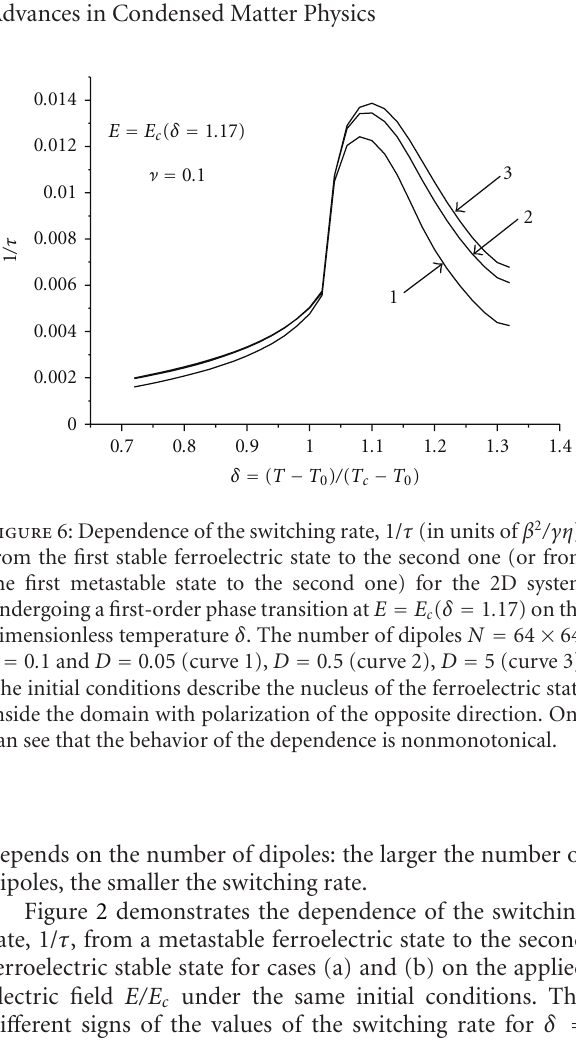
dependencies j ( t ) at E = 0 . 95 · E c and E = 1 . 05 · E c .